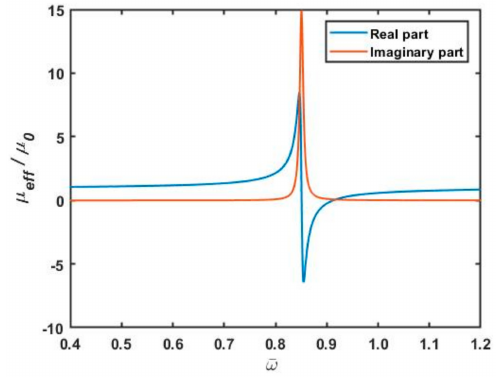
Figure 7. Effective relative magnetic permeability for bulk medium with the geometry of